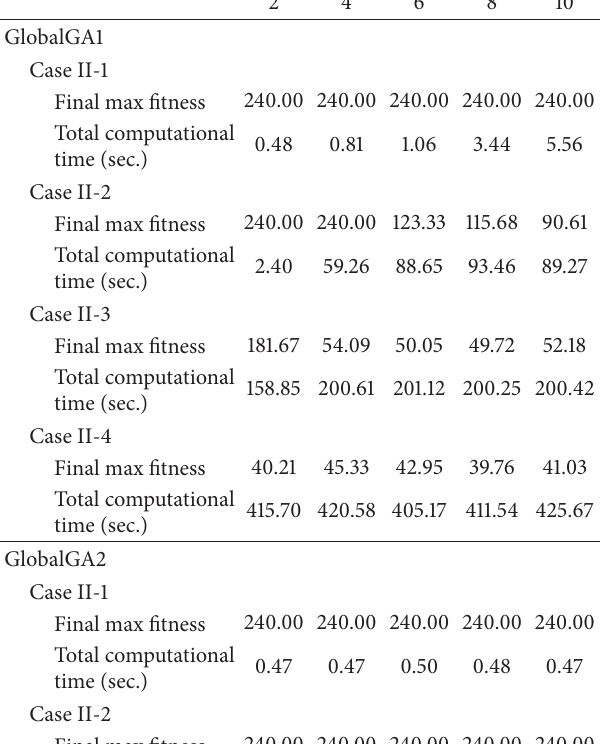
Table 5: The influence of field size on the performance of new GAs. (Ave. results of 20 exp.)